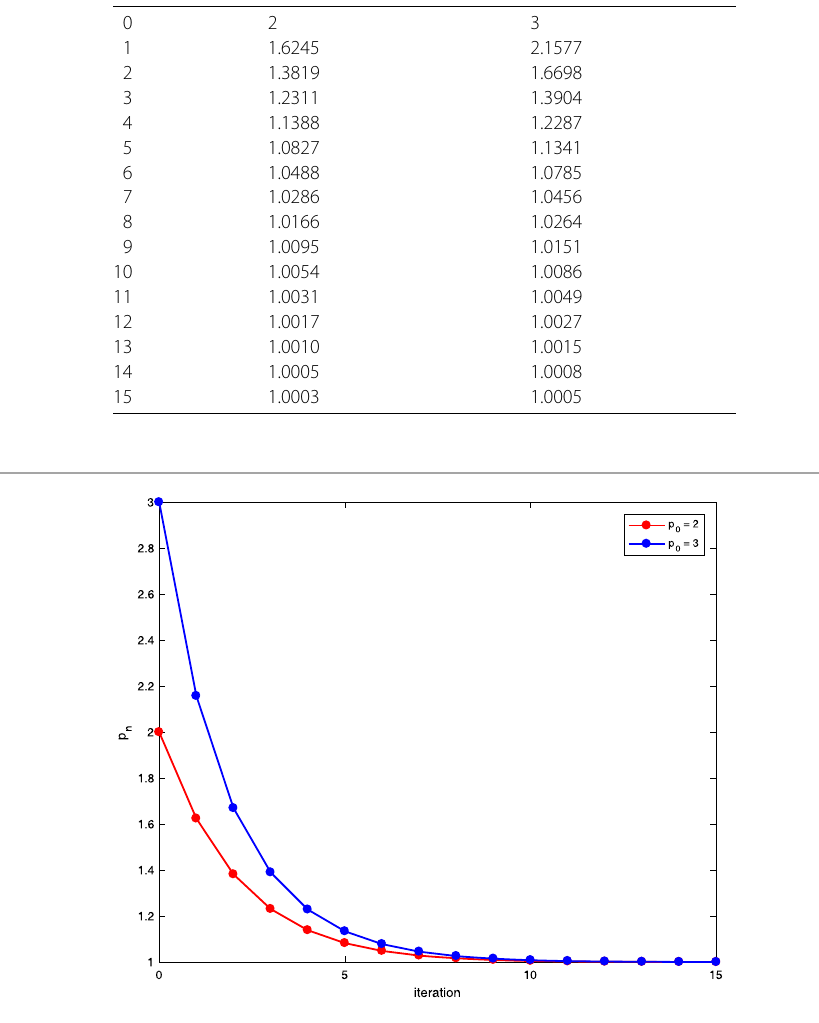
Figure 1 Iterative process of Mann-type splitting